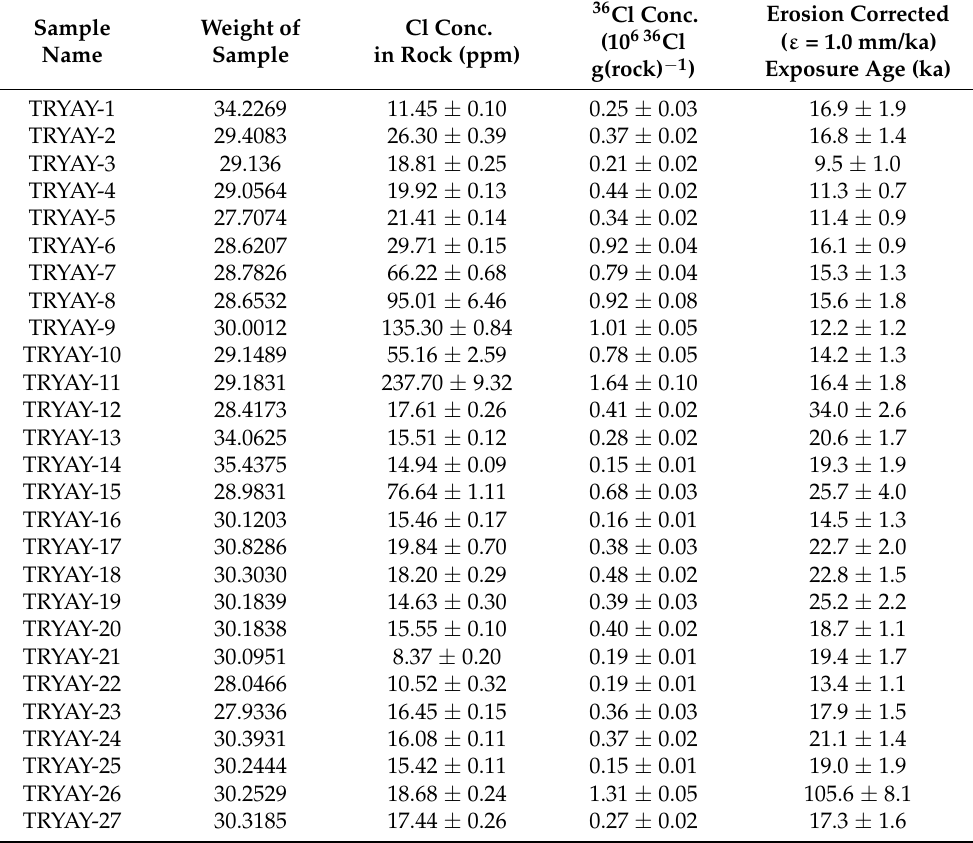
Table 2. Cosmogenic nuclide data and calculated 36 Cl exposure